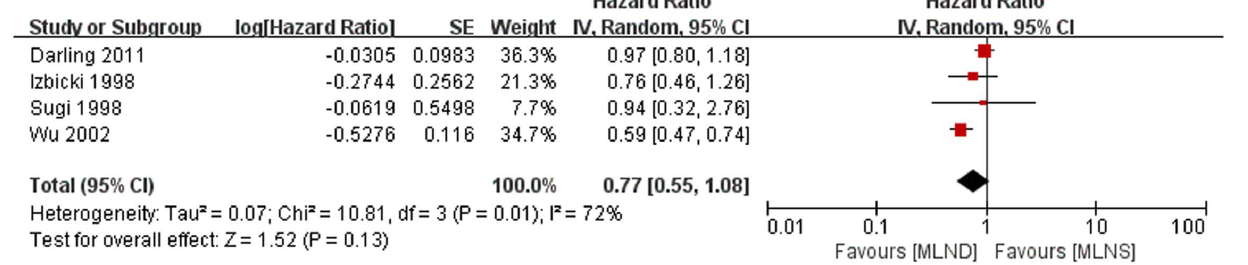
Figure 3. Forest plot of overall survival for the MLND vs. MLNS groups. MLND, mediastinal lymph node dissection; MLNS, mediastinal lymph node sampling; HR, hazard ratio; CI, confidence interval.